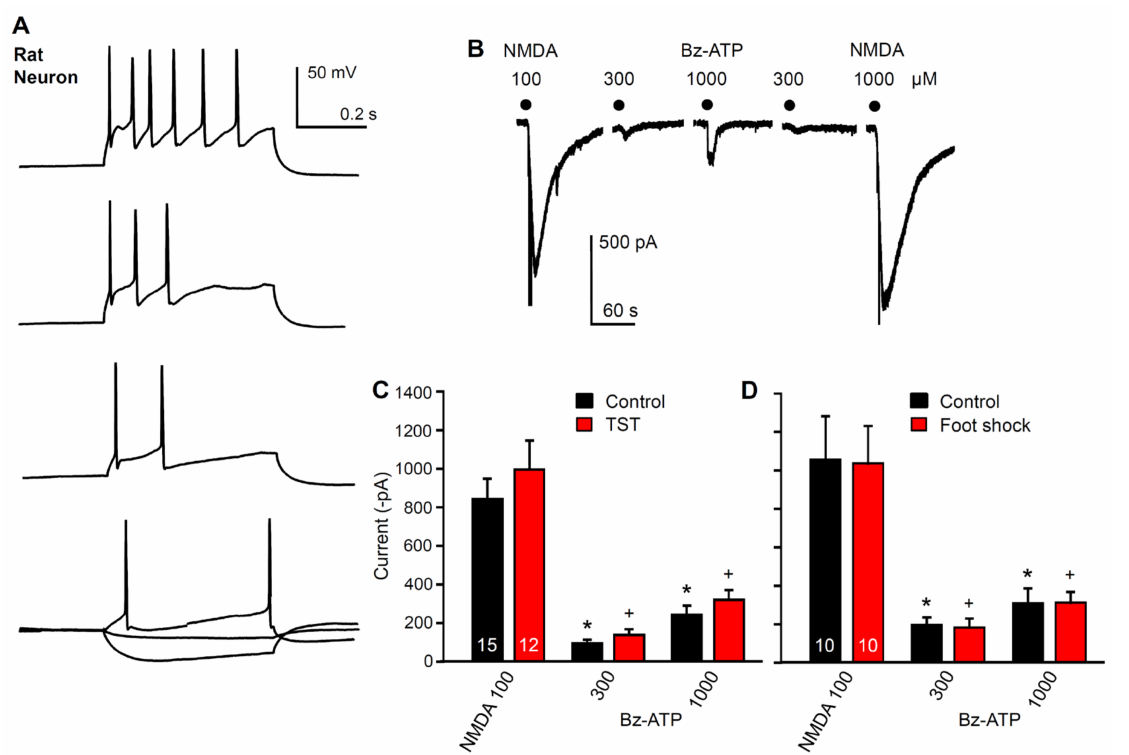
Figure 5. Effects of learned helplessness on NMDA and Bz-ATP-induced currents in hippocampal CA1 pyramidal neurons. ( A ) action potential firing caused by gradually increasing current injection into neurons discriminated thereby from astrocytes. Representative tracings. ( B ) the holding potential of the neurons was set to − 70 mV and then NMDA (100 µ M), and Bz-ATP (300, 1000 µ M) was applied for 10 s every 3 min. Representative tracing. ( C ) there was no change in the NMDA- or Bz-ATP- induced current amplitudes after the TST, when compared with the unstressed (control)